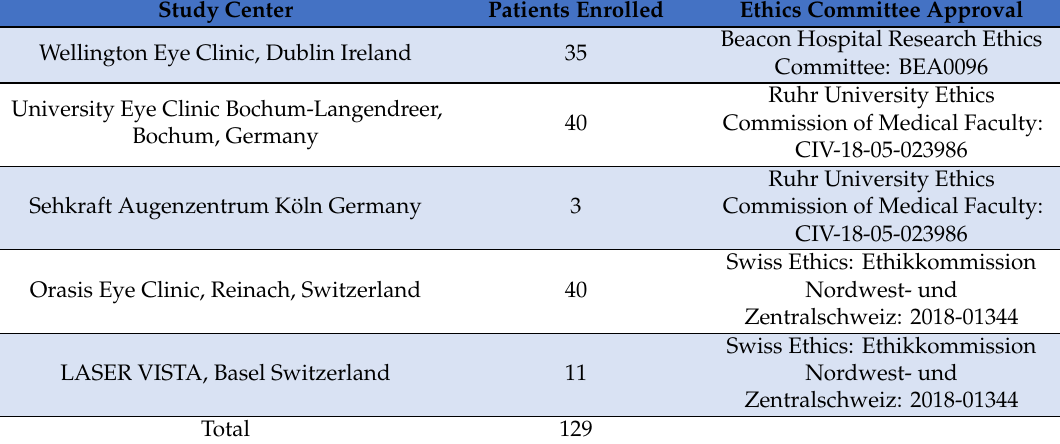
Table 1. Vivior feasibility study sites, ethics committees, and enrollment.